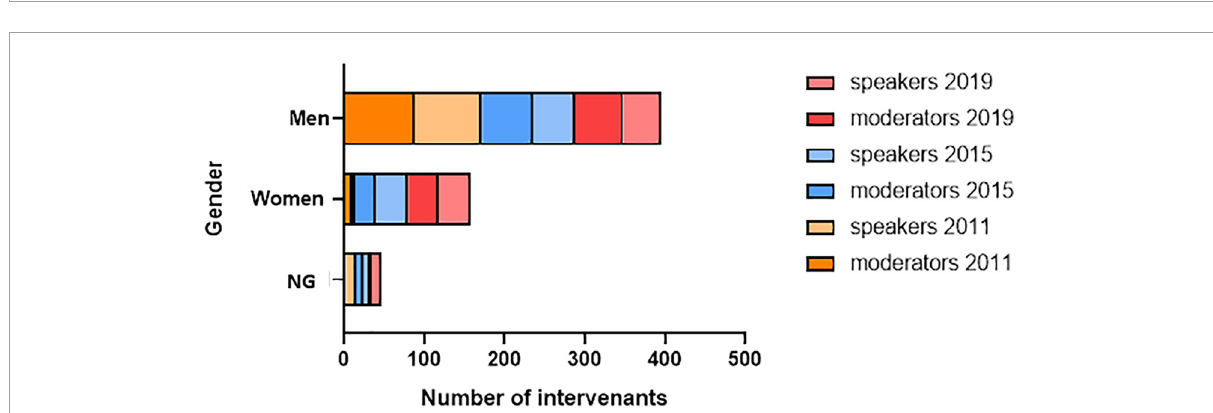
FIGURE4 Evolution of gender during the three congresses. Distribution of gender for all types of sessions (major oral sessions and industry-led symposia) by congress year and by position (speakers and moderators). Variables are presented as absolute values. NG, non-gendered.